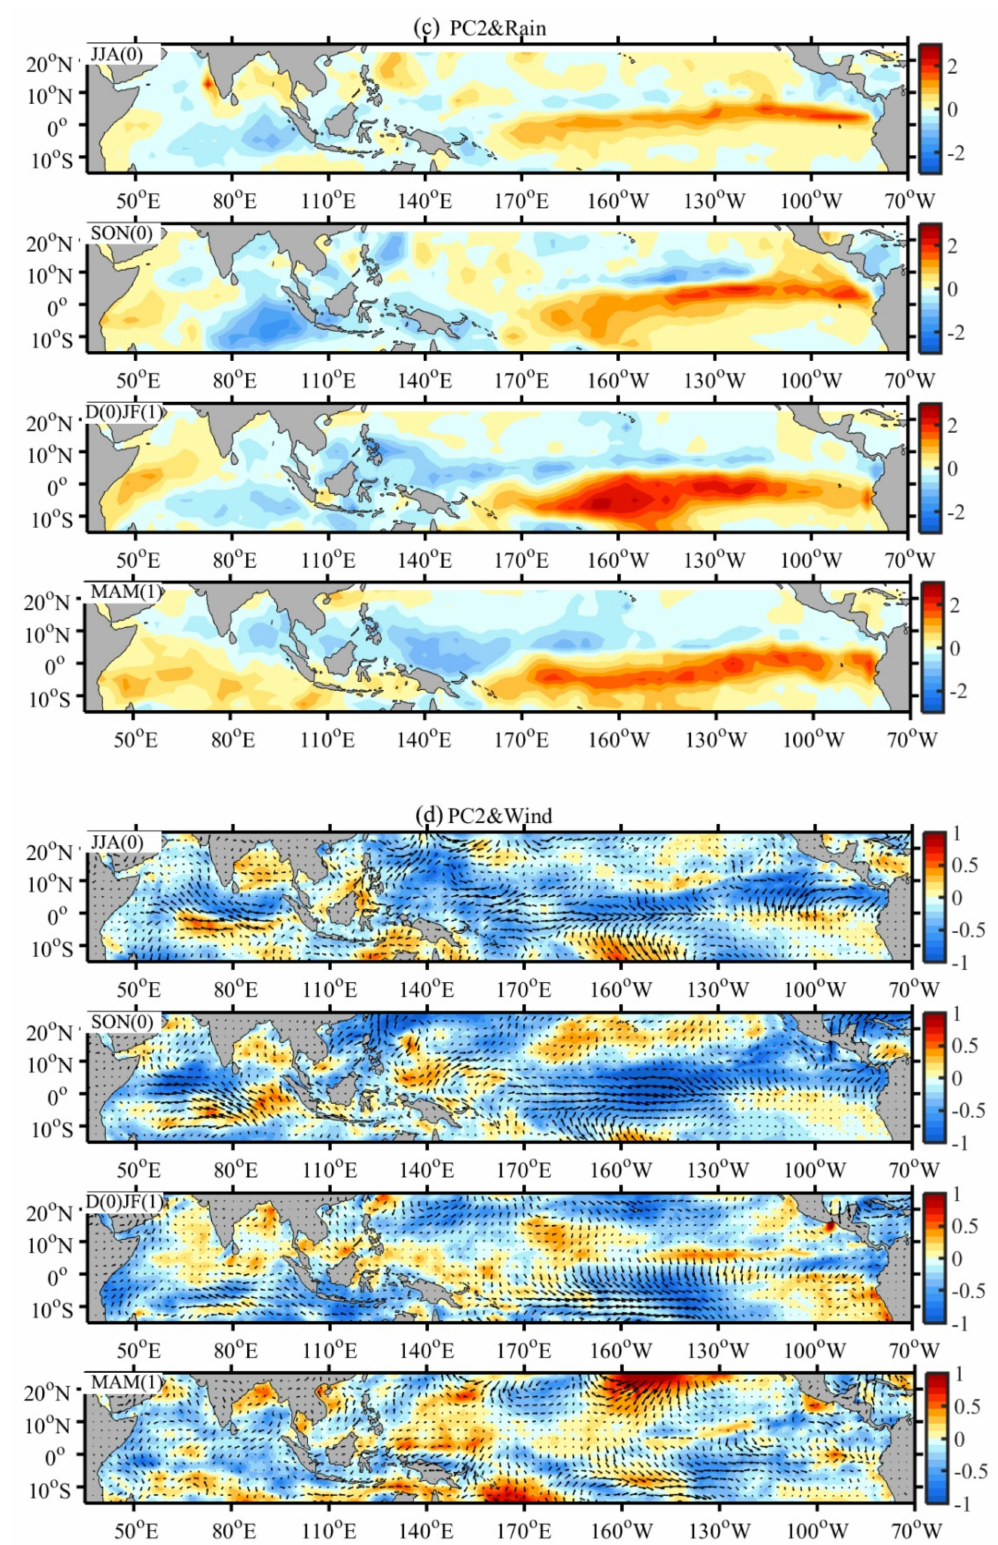
Figure 8. The same as in Figure 7, but with a one-year lead of